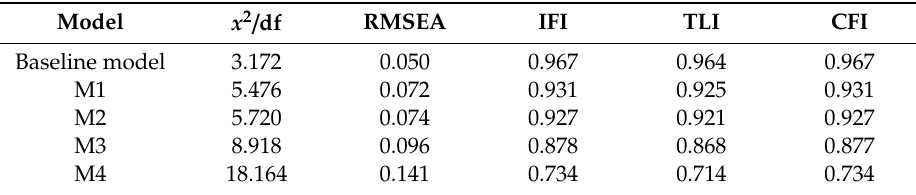
Table 2. Comparison of measurement models.